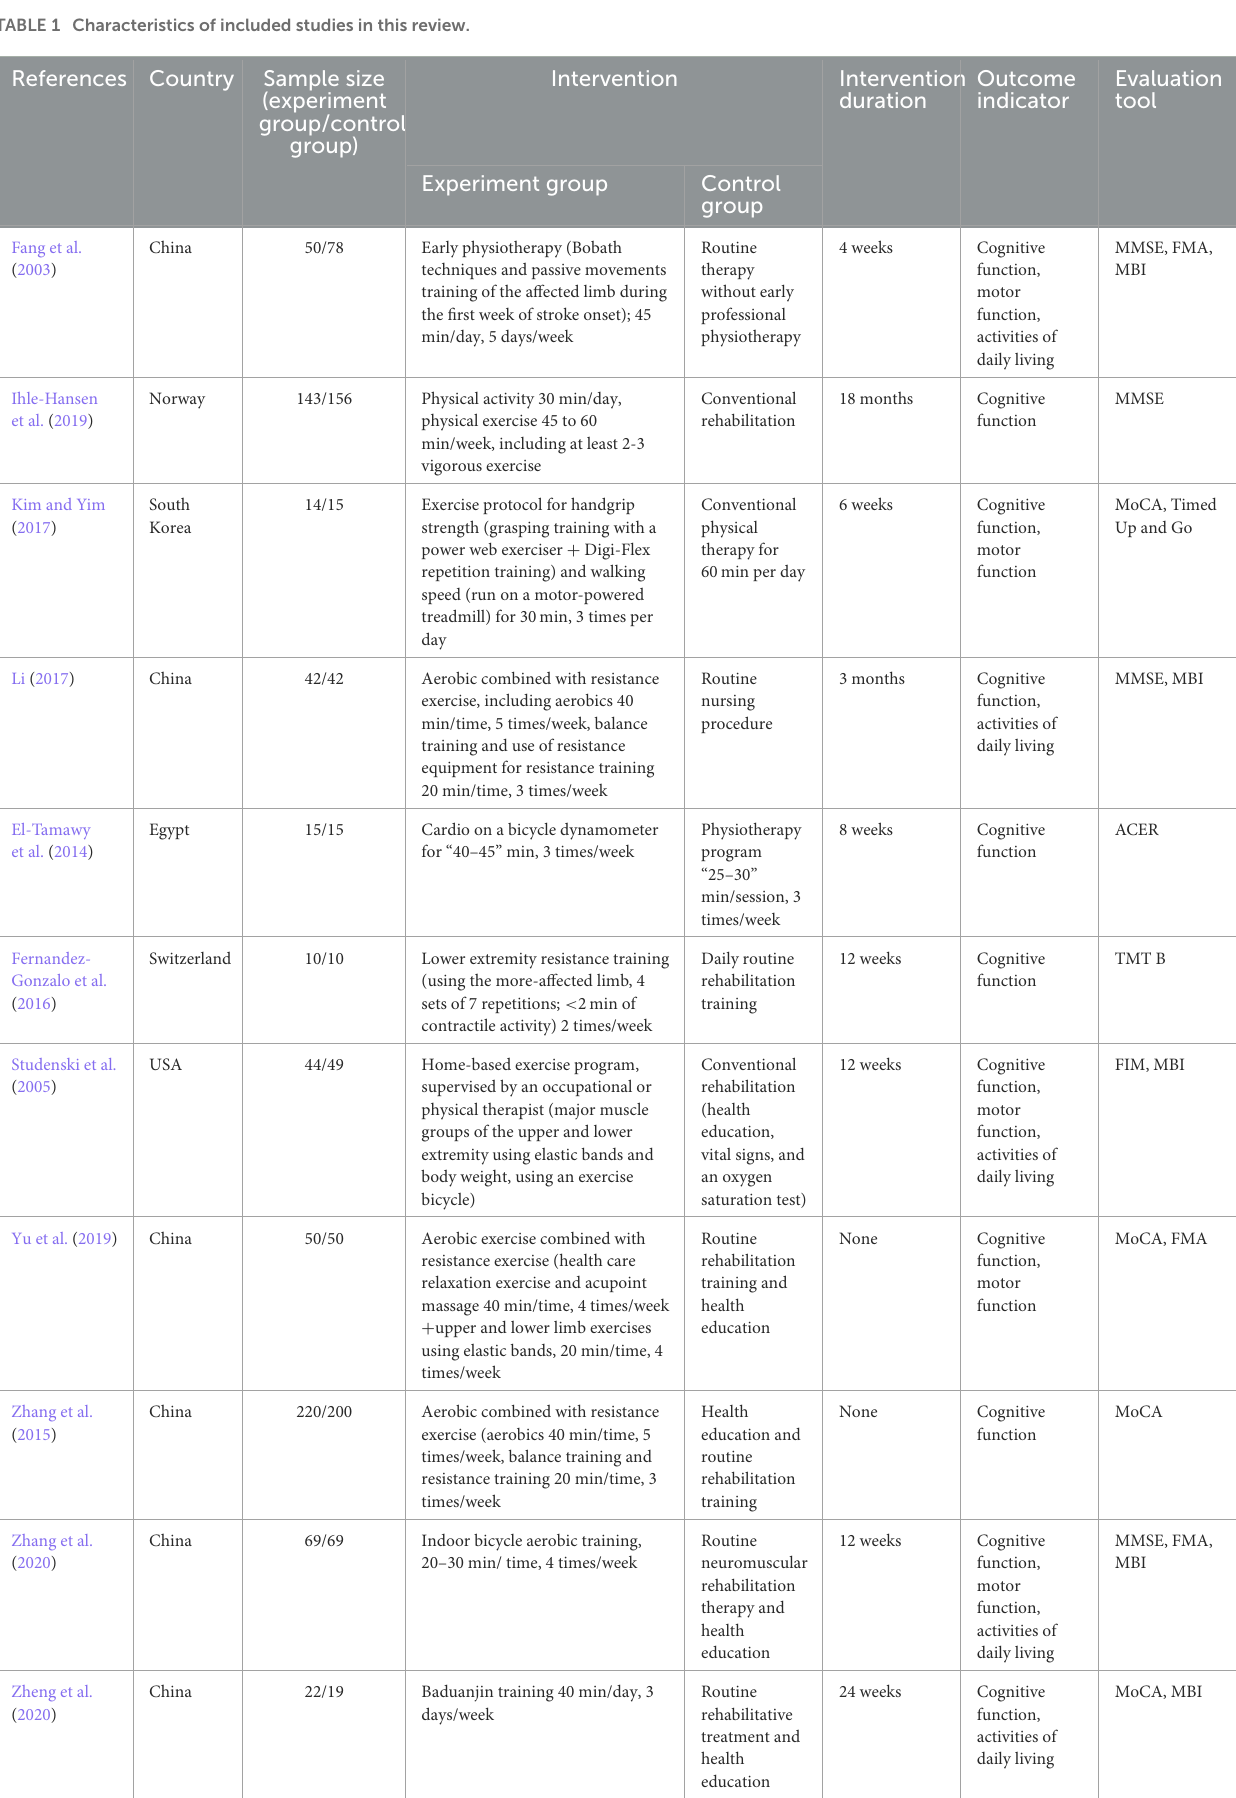
TABLE 1 Characteristics of included studies in this